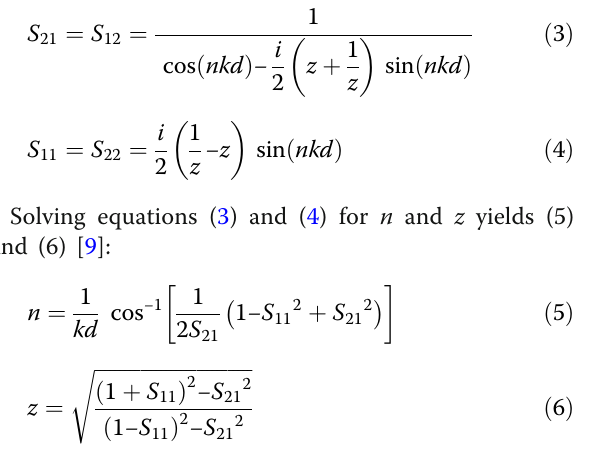
And the S matrix is symmetric. Using the information in equation (1), (3) and (4) can be derived: